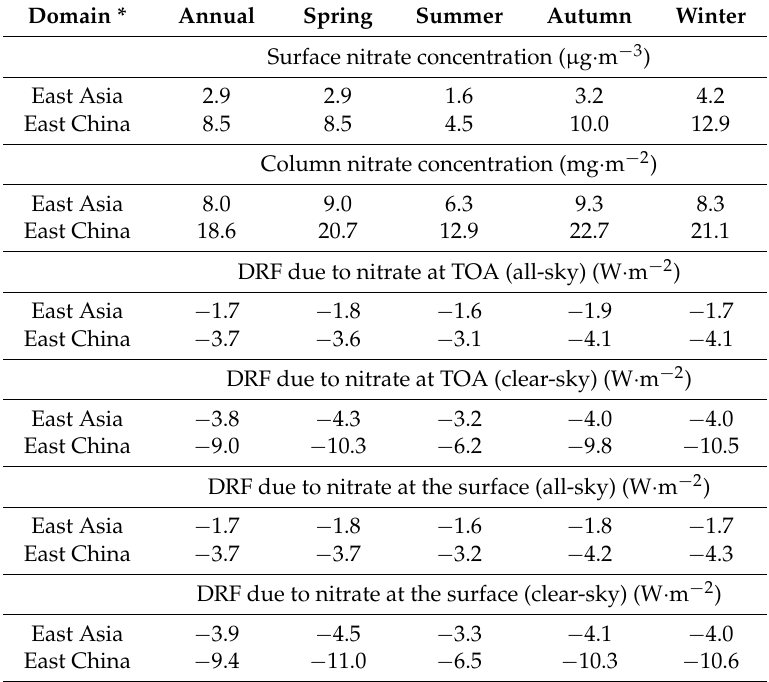
Table 3. Domain averages of annual and seasonal mean surface nitrate concentration, column nitrate concentration, and direct radiative forcing (DRF) due to nitrate at the top of the atmosphere (TOA) and at the surface under all-sky and clear-sky conditions for East Asia and east China.